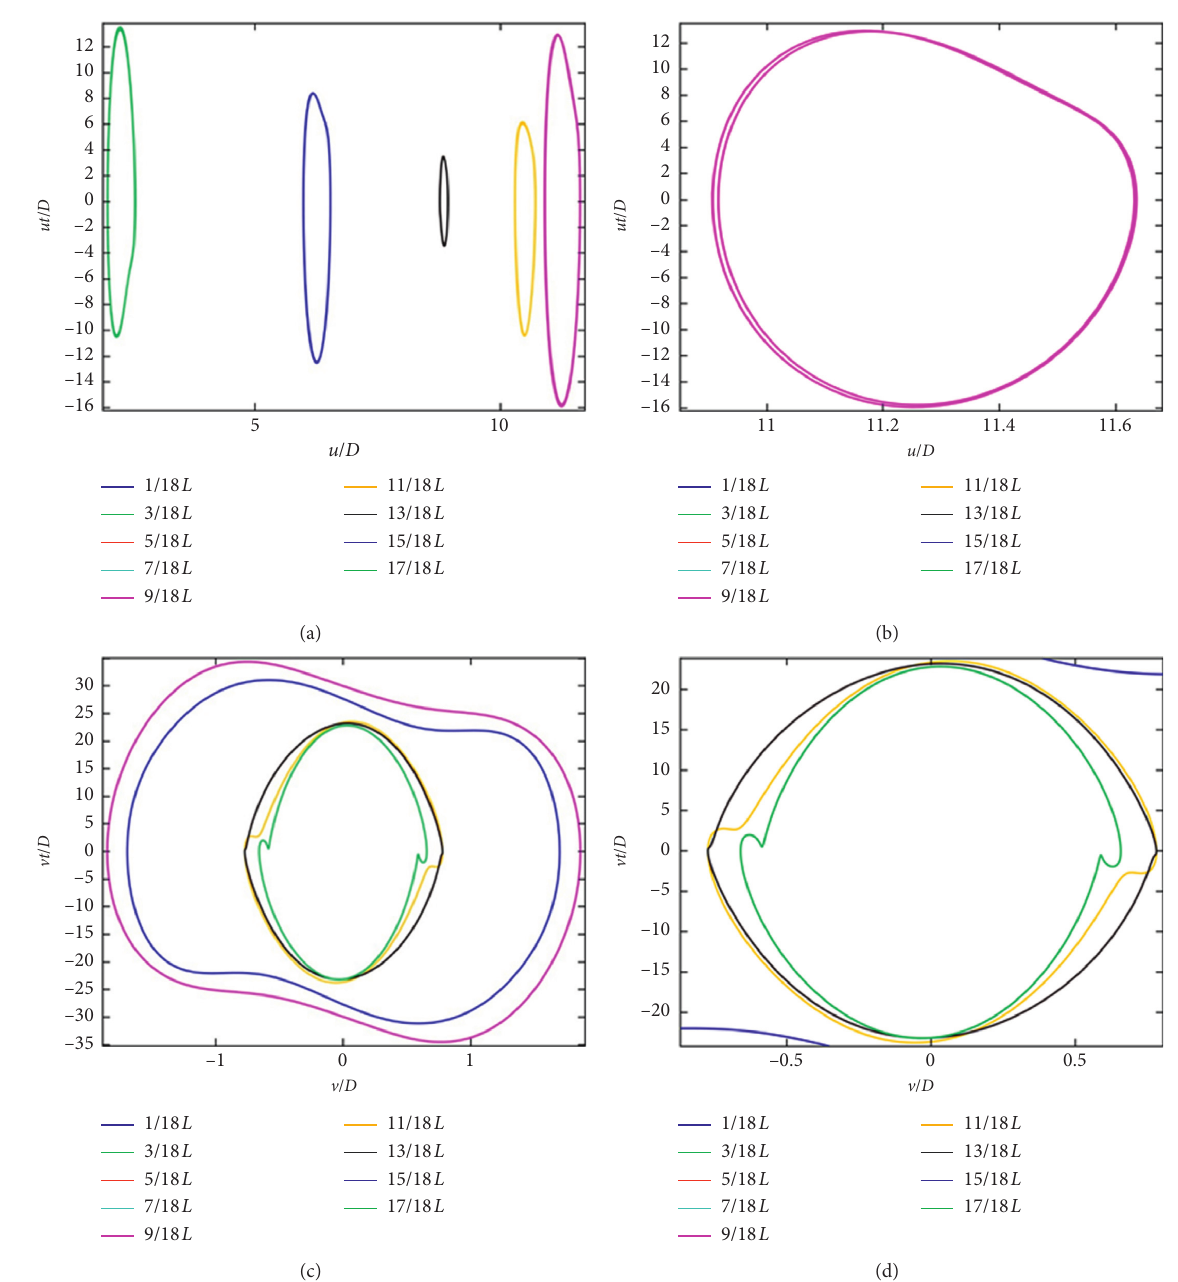
Figure 4: The phase diagram of the marine riser considering the coupling effect: the phase diagram (a) and partial enlargement diagram (b) of the cross-flow and the phase diagram (c) and partial enlargement diagram (d) of the